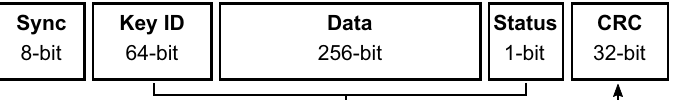
Figure 5. The format of the secret keys retrieved from the QKD system. Sync: Synchronization, a 8-bit to determine the start of a frame. Key ID: 64-bit key counter. Key Data: 256-bit Secret key. Key Status: 1-bit